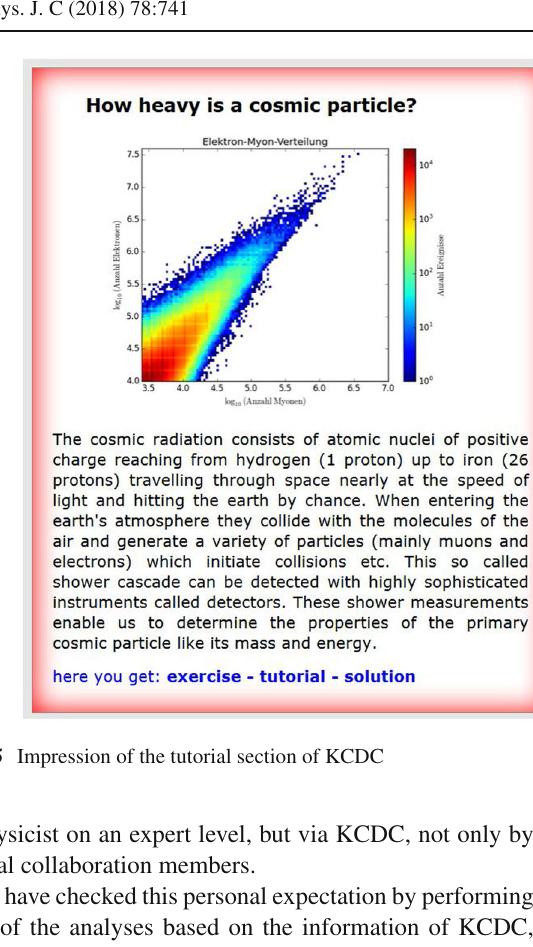
by physicist on an expert level, but via KCDC, not only by internal collaboration